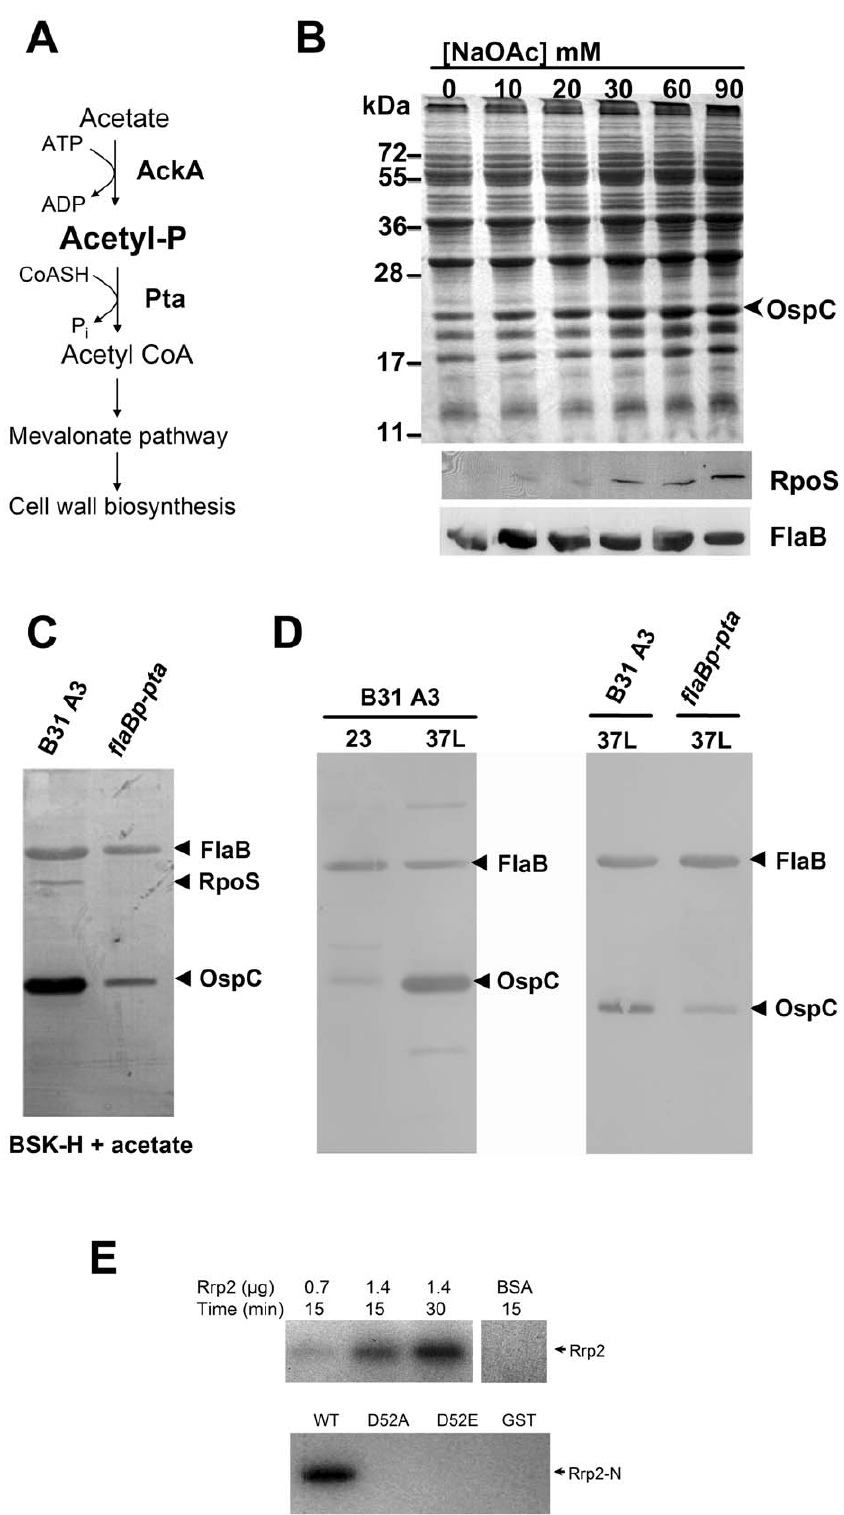
Figure 7. Acetyl , P plays an important role in Rrp2 activation under invitro cultivation conditions. ( A ) Diagram of the ACK-PTA pathway in B. burgdorferi . ack ( bb0622 ) encodes acetate kinase (Ack), which converts acetate to the intermediate acetyl , P, while pta (bb0589) encodes phosphate acetyltransferase (Pta), which synthesizes acetyl-CoA from acetyl , P and CoASH [17]. In B. burgdorferi , the Ack-Pta pathway appears to be the sole pathway for biosynthesis of acetyl-CoA, a molecule required for cell membrane biosynthesis (see Results and Discussion for details). ( B ) Acetate induces activation of the Rrp2-RpoN-RpoS pathway. Wild-type B. burgdorferi strain B31-A3 was cultivated in the BSK-H medium supplemented with 0–90 mM NaOAc with a final media pH value of 7.0. Cells were harvested at the early-logarithmic phase (5 6 10 6 spirochetes/ml).